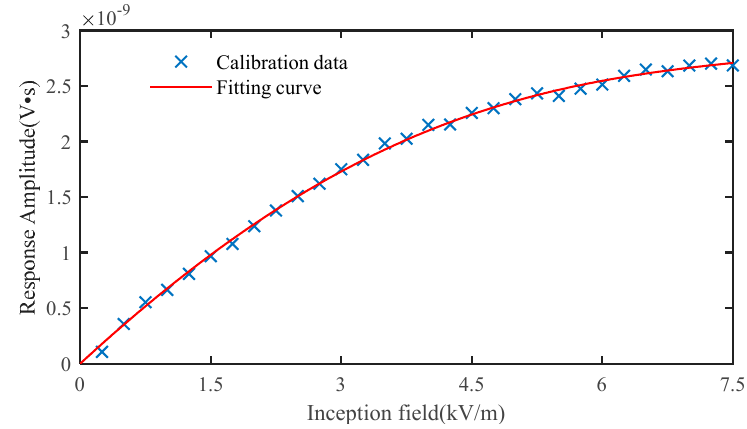
Figure 7. Identification results of the nonlinear element of D-dot sensor.